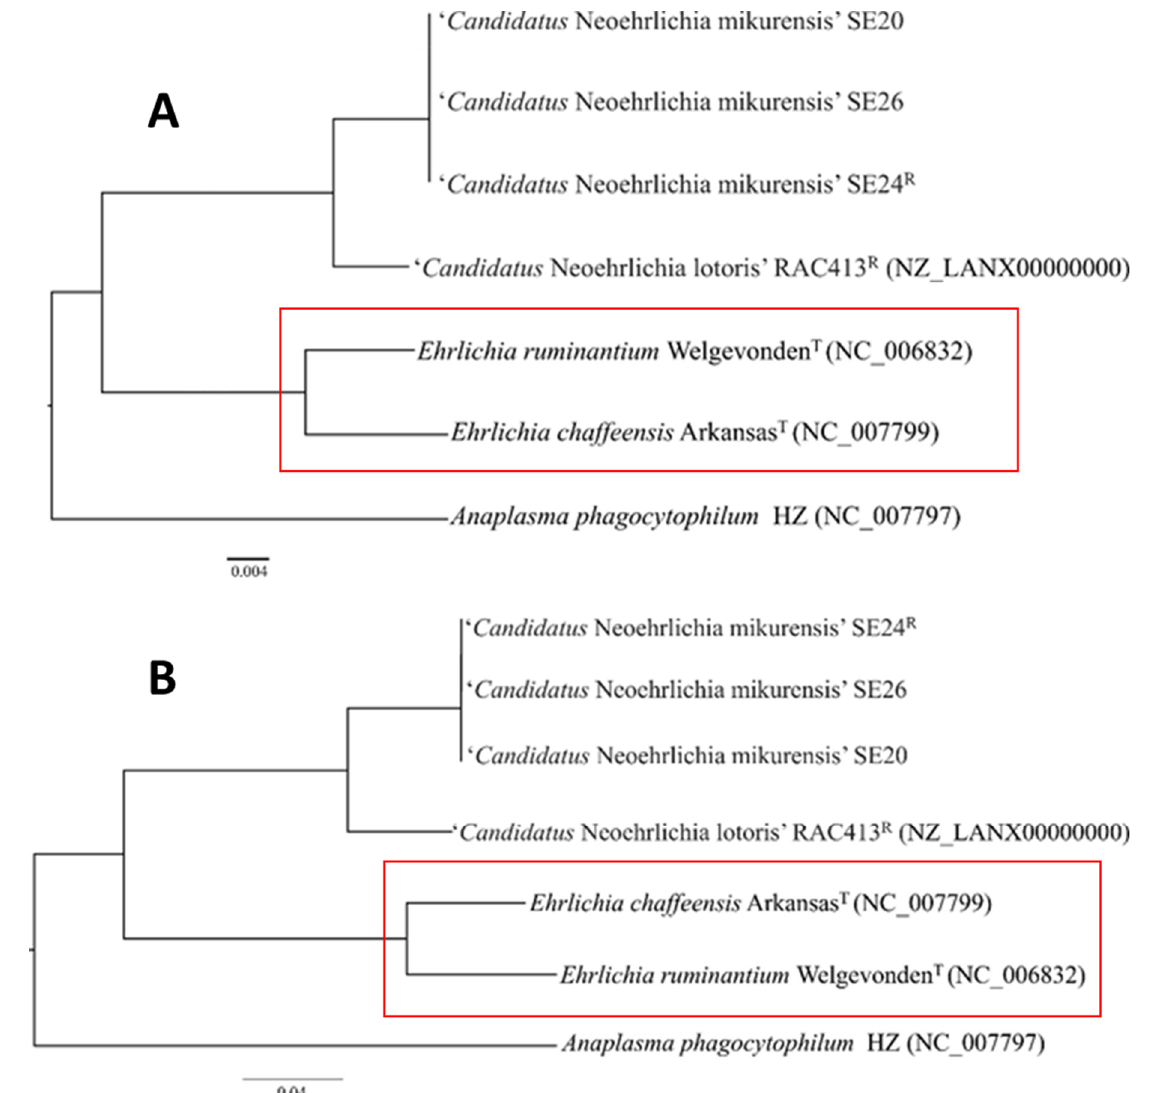
Figure 4. ( A ) Phylogenetic tree based on comparisons of the complete 16S rRNA gene sequences obtained from the genomes analyzed in this study. The scale bar indicates number of nucleotide subsitutions per site. ( B ) Core-genome dendrogram based on 93 shared core-proteins identified in this study. Marked in red is the switch in bacterial relatedness seen when a higher resolution phylogenetic analysis was used ( B) vs. ( A ). The scale bar indicates aminoacid substitutions per site.